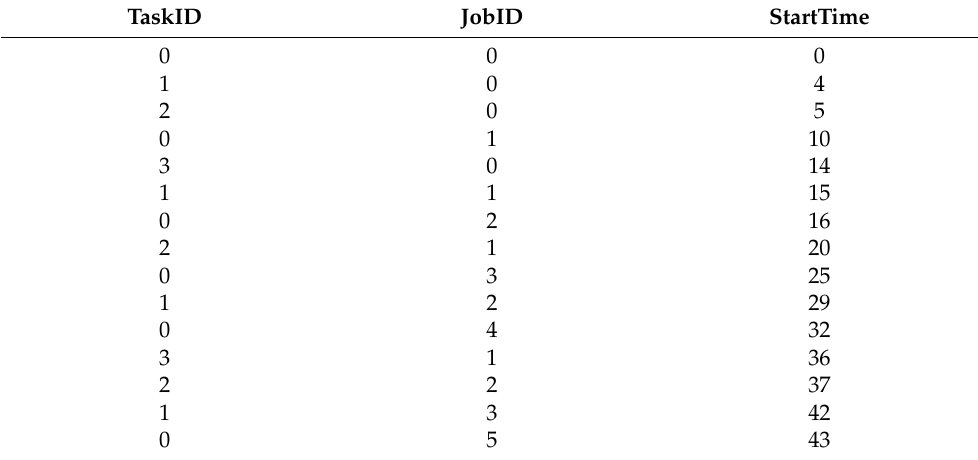
Table 2. Lo-criticality mode scheduling table for the task set in Table 1. TaskID